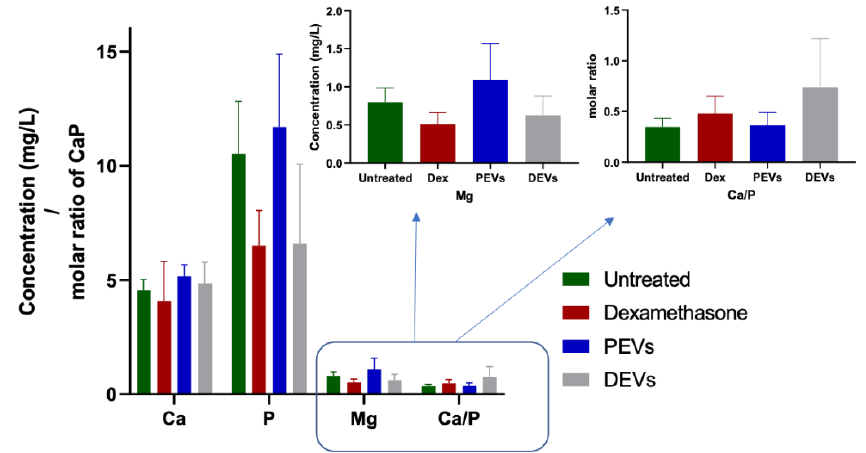
Figure 4. The quantification of intercellular Ca, P, Mg, and molar ratio of Ca/P. Results represent average of three independent experiments carried out in quadruplicate (SD values, n = 3).